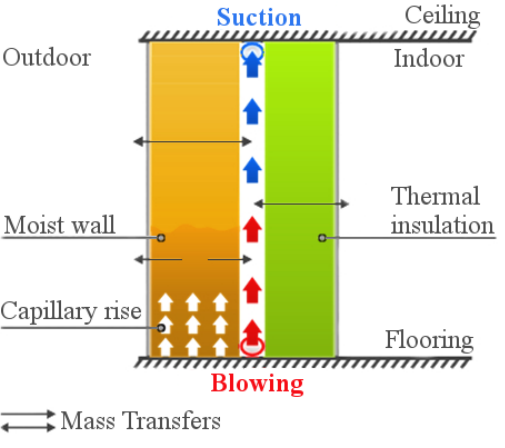
Figure 1. Principle of ventilation technology.